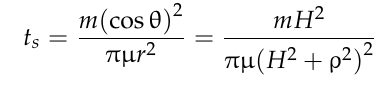
Figure 6. Flat plate substrate holder, where H is the distance between the source and the substrate holder; φ is the angle between the normal of the source and the line connecting the source and the P point; θ is the angle between the normal of the substrate and the line connecting the source and the